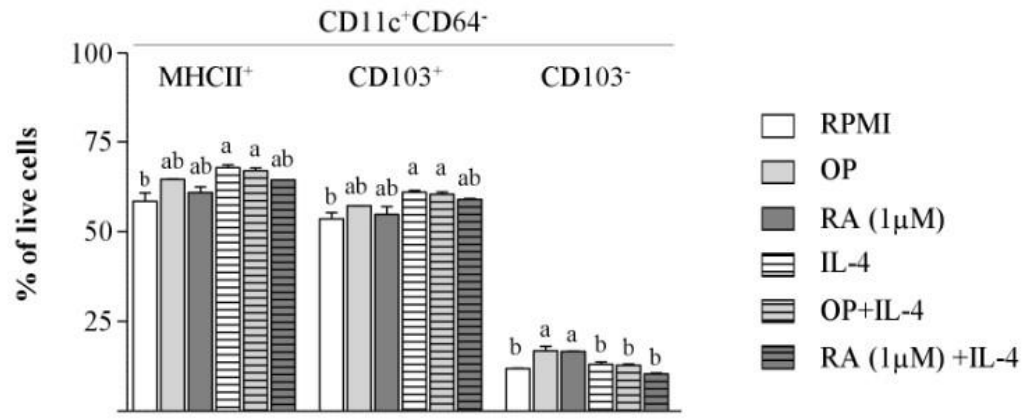
Figure 2. OP increases the proportion of CD11 + CD64 - CD103 - cells in BM-DC cultures. BM-DCs from naïve mice were cultured for 24 h without stimuli (RPMI), or with OP, RA, IL-4, OP+IL-4, or RA+IL-4. The percentage of MHCII + , CD103 + , and CD103 - DCs (CD11c + CD64 - ) cells within the total population of live cells was assayed by flow cytometry. Results of a representative experiment performed in triplicate are shown. Data are means ± SEM. Different letters indicate statistically significant differences ( p < 0.05) calculated using one-way analysis of variance (ANOVA), followed by Tukey’s post-hoc test.